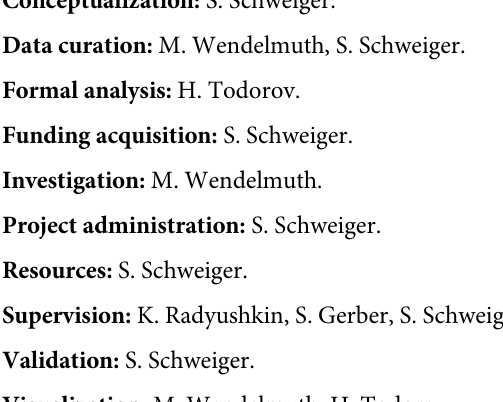
S8 Fig. Exploration times measured in novel object recognition testing of animals in Fig 3 at three different time point. T2: 8–10 days post exposure. T3: 22–24 days post exposure. T4: 43–45 days post exposure (T2 vs. T3 p = 0.0551, T2 vs. T4 p = 0.0071, T3 vs. T4 p > 0.9999, ANOVA and Bonferroni’s multiple comparisons test). Data are shown as mean + standard error of the